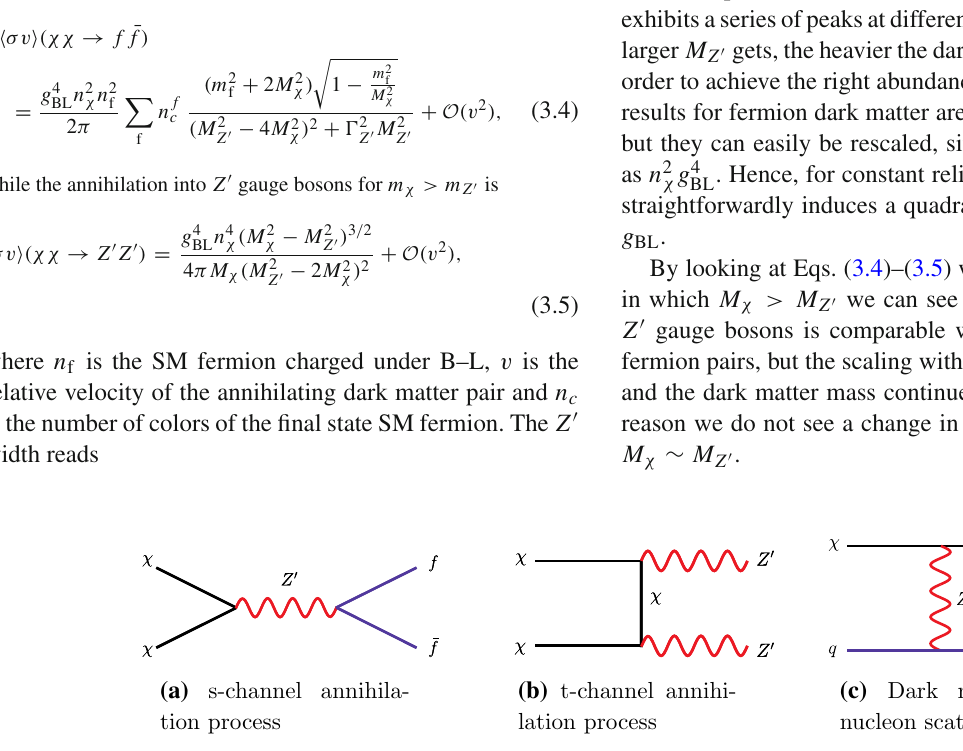
Fig. 1 Darkmatterannihilationanddarkmatter–nucleonscatteringprocessesinthefermiondarkmattermodel,where f standsforallSMfermions and q represents the quarks. The t -channel annihilation process is only relevant for M χ > M Z